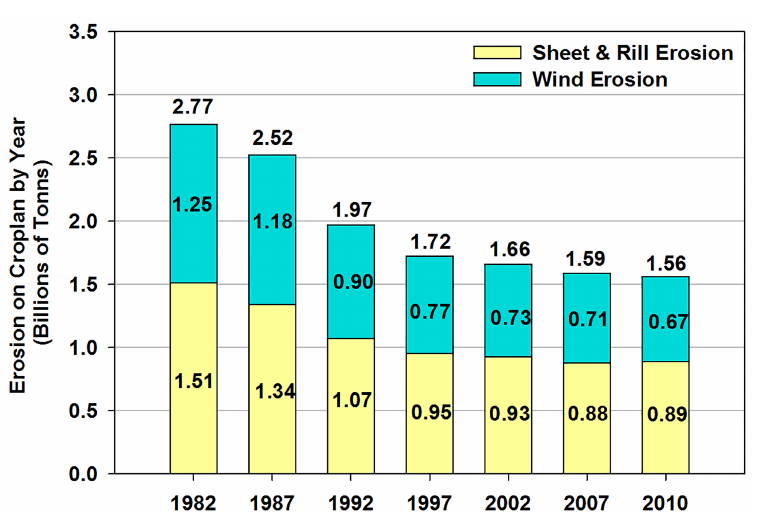
Fig 2. Cropland represents cultivated and non-cultivated cropland. Reductionin croplanderosion process, water and wind erosion, aroundthe United State of America from 1982 to 2010. Figure is adapted and reconstructed into metric tons (Tonns) from data providedby U.S. Departmentof Agriculture, Summary Report : 2010 NationalResourcesInventory , Natural Resources ConservationService, September 2013. Courtesyof USDA’s NaturalResourcesConservation Service (NRCS). http://www.nrcs.usda.gov/Internet/ FSE_DOCUMENTS/stelprdb1167354.pdf.